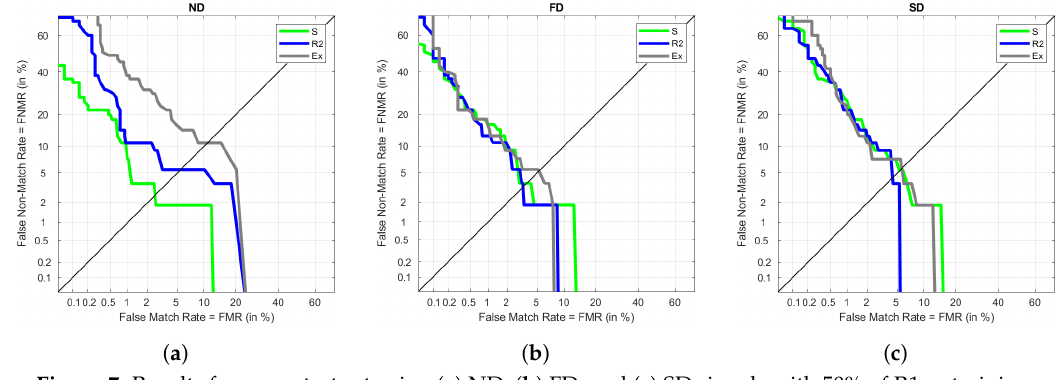
Figure 7. Results for every test set using ( a ) ND, ( b ) FD, and ( c ) SD signals with 50% of R1 as training.